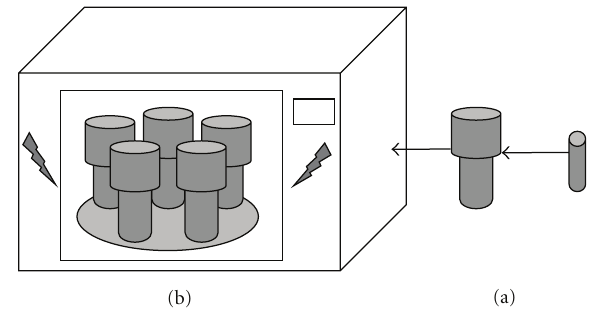
Figure 1: Microwave-assisted solvothermal reaction apparatus (a) Teflon reaction vessel, (b) microwave reaction apparatus (ACTAC Co.,